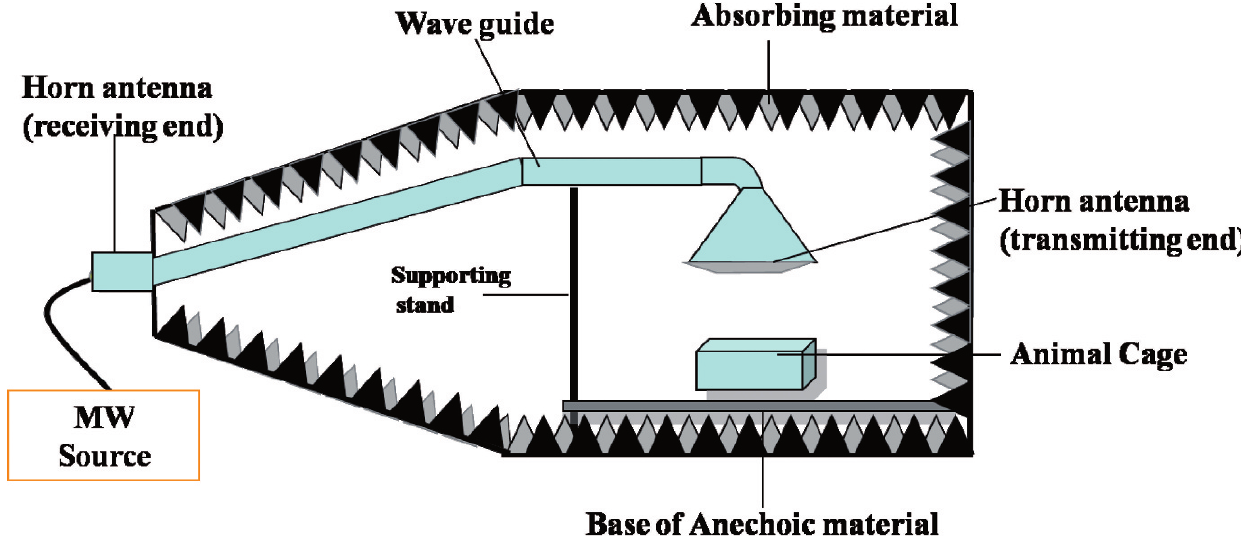
Figure 2 - Schematic layout of the 2.45-GHz exposure device.